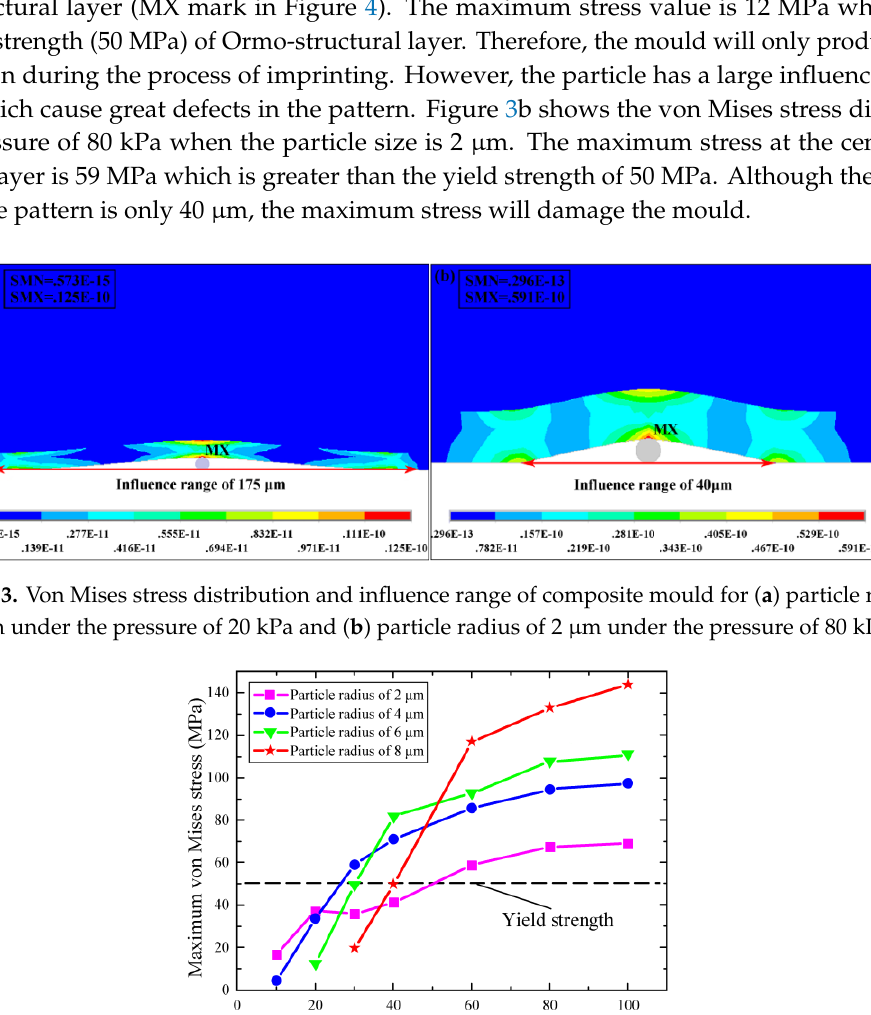
Figure 3. Von Mises stress distribution and influence range of composite mould for ( a ) particle radius of 6 μm under the pressure of 20 kPa and ( b ) particle radius of 2 μm under the pressure of 80 kPa.